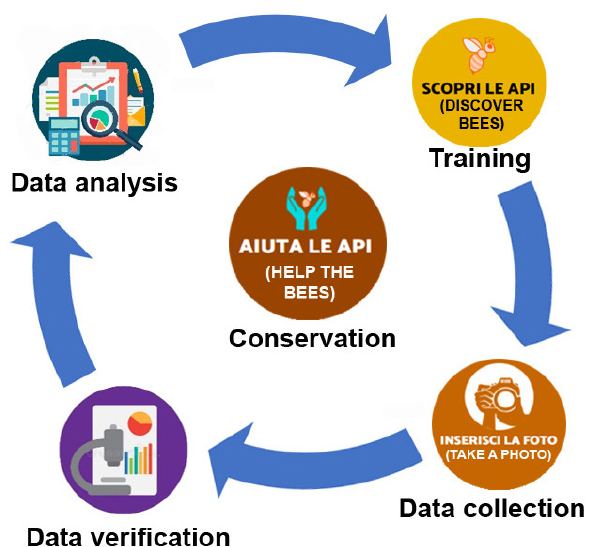
Figure 1. Circular process underlying the project: training, data collection, data verification, data analysis and new training; the final purpose is bee conservation.